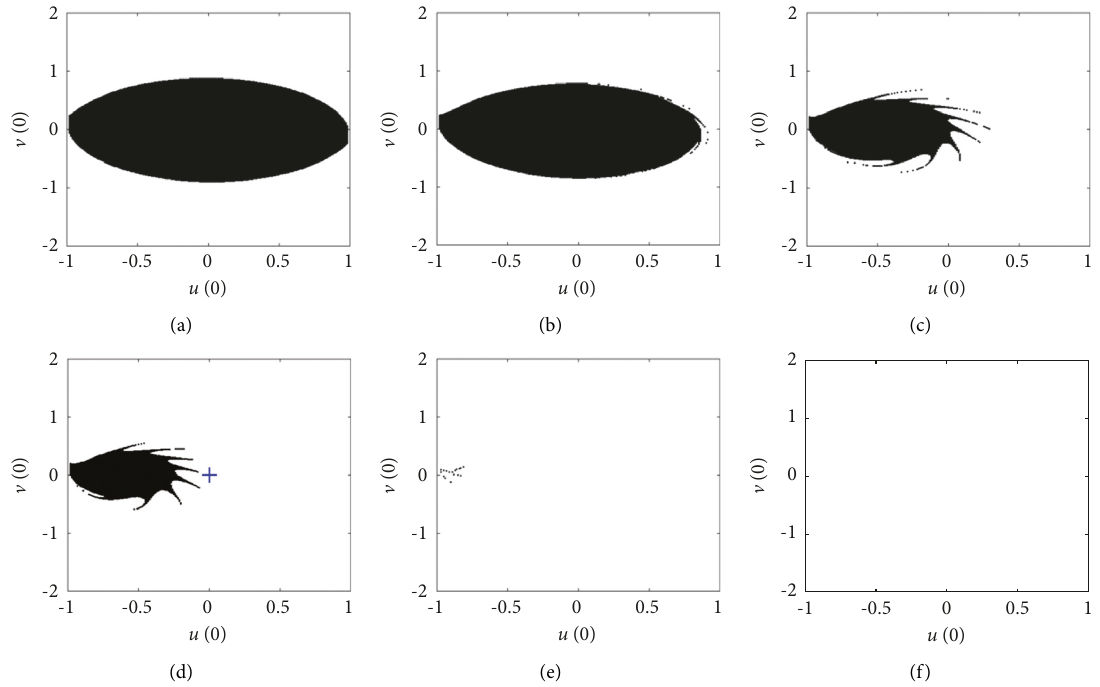
Figure 5: Evolution of safe basins of system (2) with the increase of f � 0 . 42. (e) f f 0